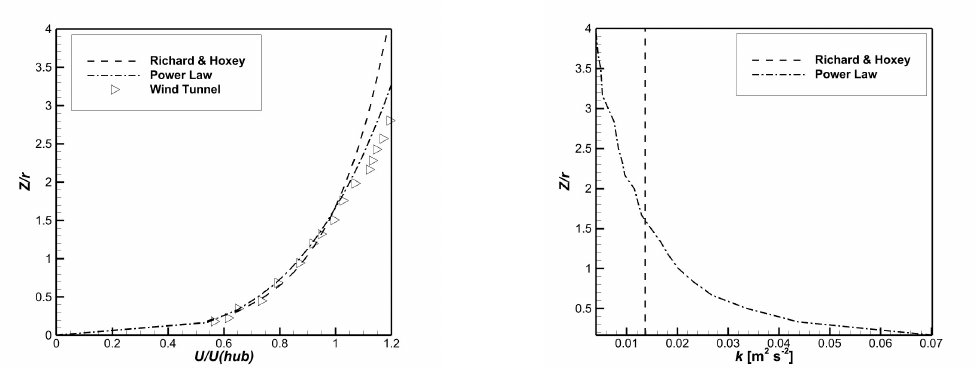
Figure 2. Power law and logarithmic profiles at the inlet, velocity profile ( left ) and turbulence kinetic energy (m 2 /s 2 ) ( right